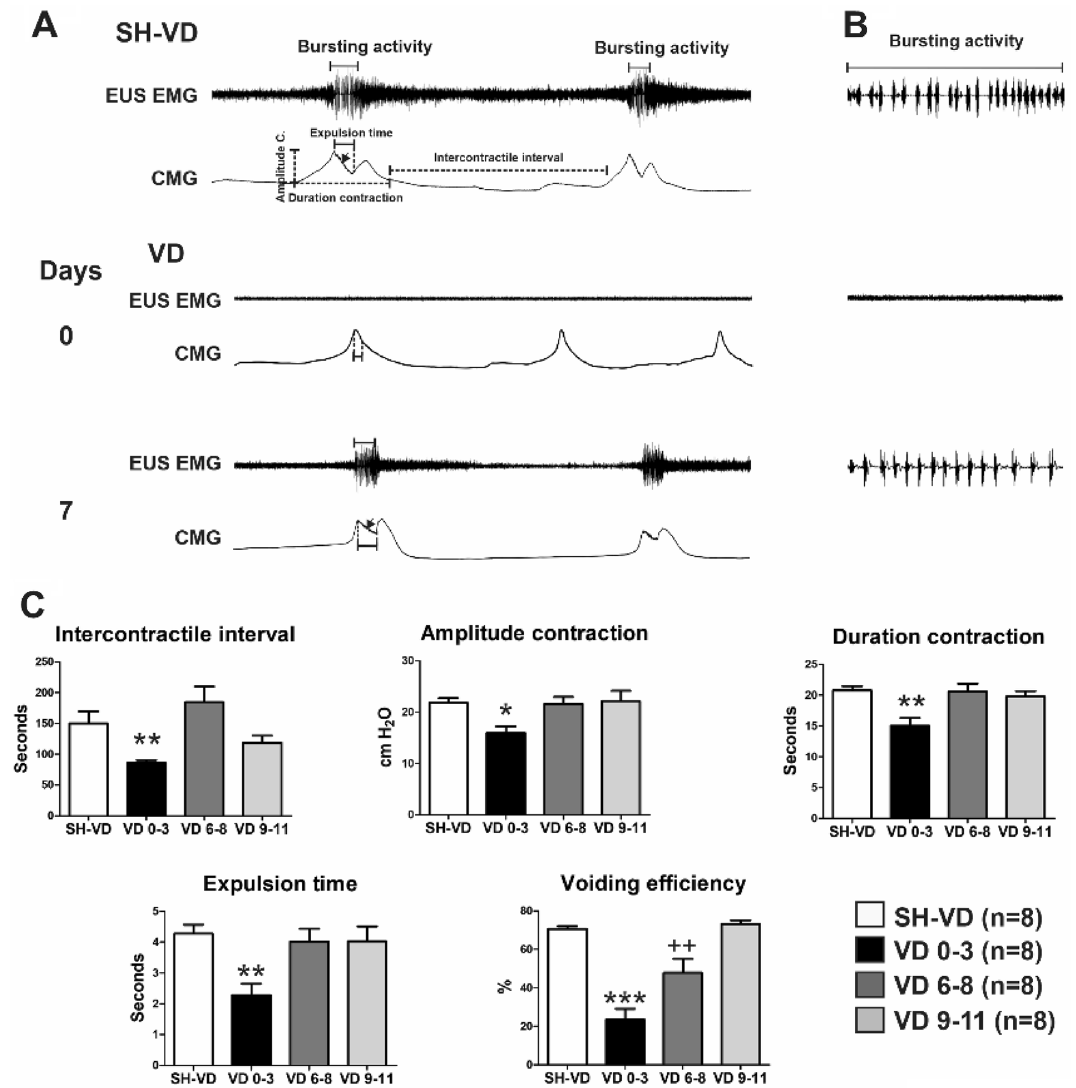
SH-VD rats (upper trace in A ), and immediately after VD, and at day 7 following VD. ( C ) Graphs depicting cystometric parameters from SH-VD and VD rats from immediate to 3, 6–8 and 9–11 days post-VD. Values are mean ± standard error of the mean. * ( p < 0.05), ** ( p < 0.01) and *** ( p < 0.001) indicate significant differences for 0–3 days after VD vs. SH-VD and VD on days 6–8 and 9–11. ++ ( p < 0.01) indicates significant differences at 6–8 days after VD vs. SH-VD rats (One Way